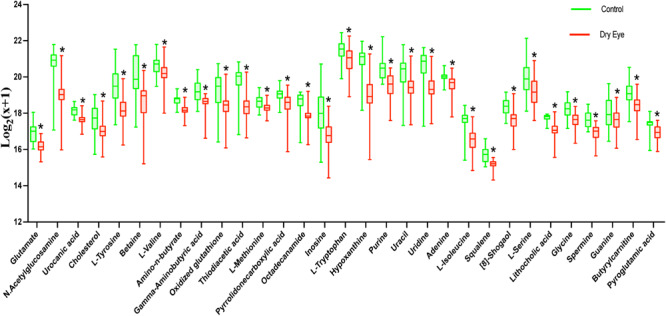
The 31 decreasing metabolites presented by relative expression in the boxplot. *P < 0.05.